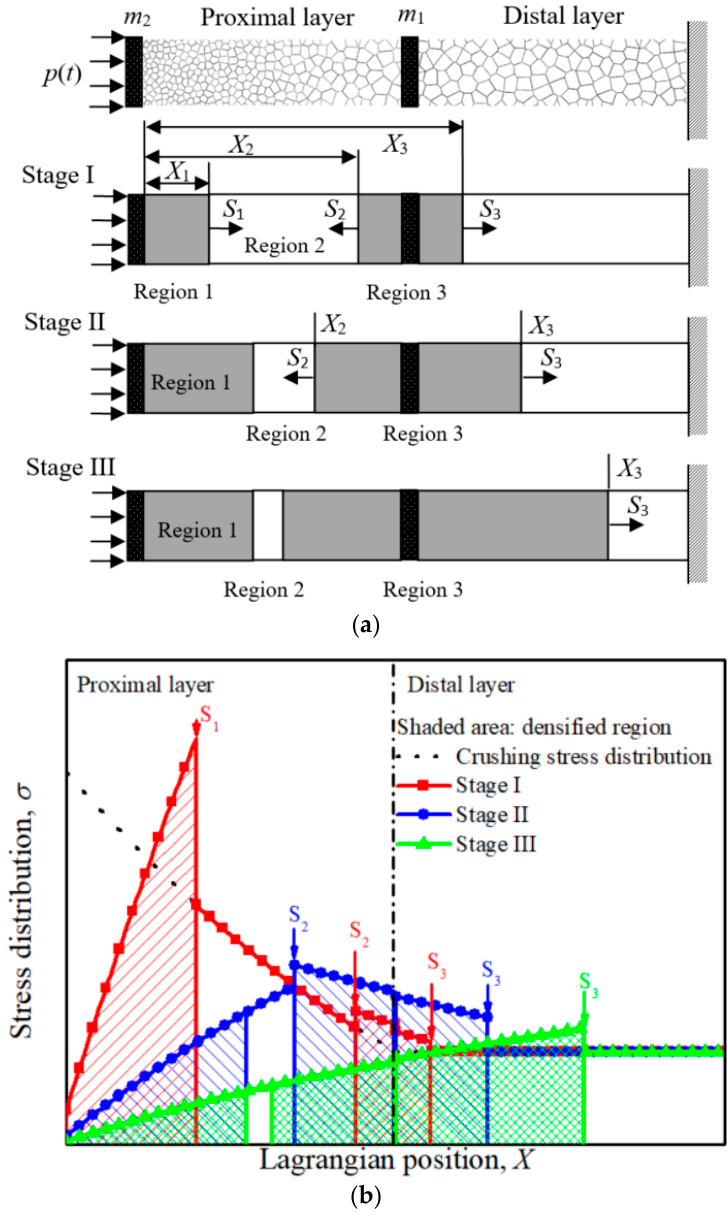
Figure 4. ( a ) The deformation diagram and ( b ) the stress distributions of NG-U cladding subjected to blast loading.